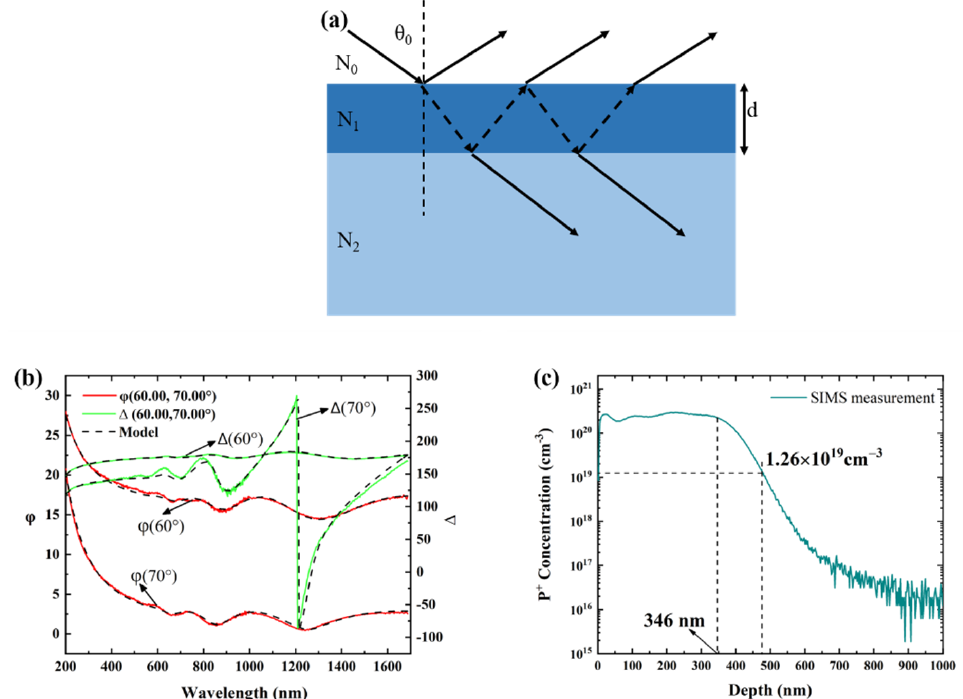
Figure 1. ( a ) Three-phase (ambient/film (i.e., ion − damaged layer)/substrate) optical model, where d is the film thickness and N is the refractive index; ( b ) Experimental (solid line) and fitted (dashed line) curves of the ion-implanted sample tested by ellipsometer, where ϕ and ∆ are used as ellipsometry parameters; ( c ) Box profile of P ions implantation formed by multiple implants. The implantation profile was measured by SIMS.